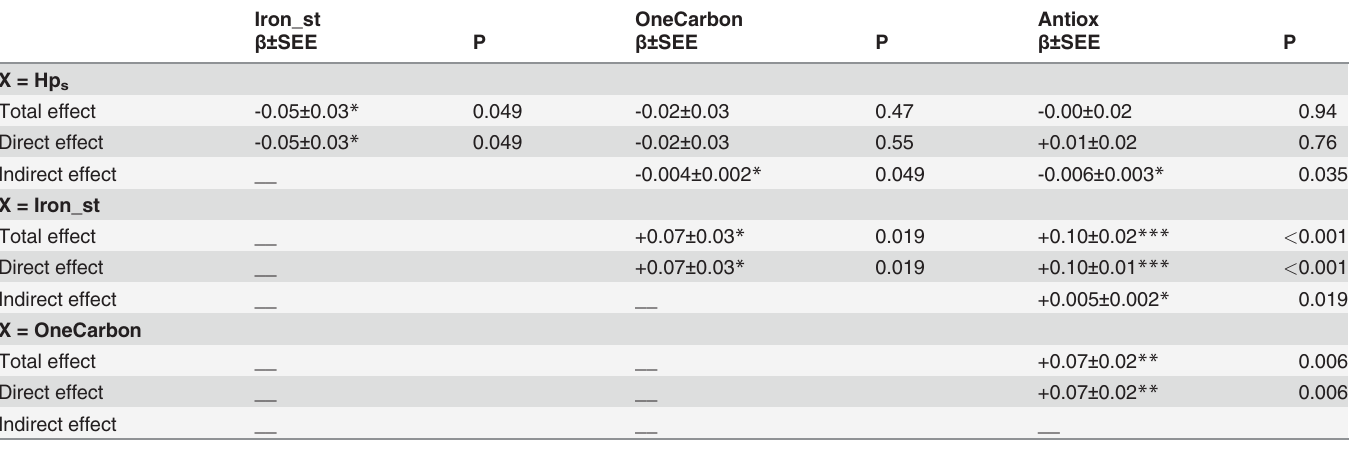
Table 4. Total, direct and indirect effects of Hp s on iron status, 1-C metabolites and antioxidant status (N = 3,057): NHANES 1999 –